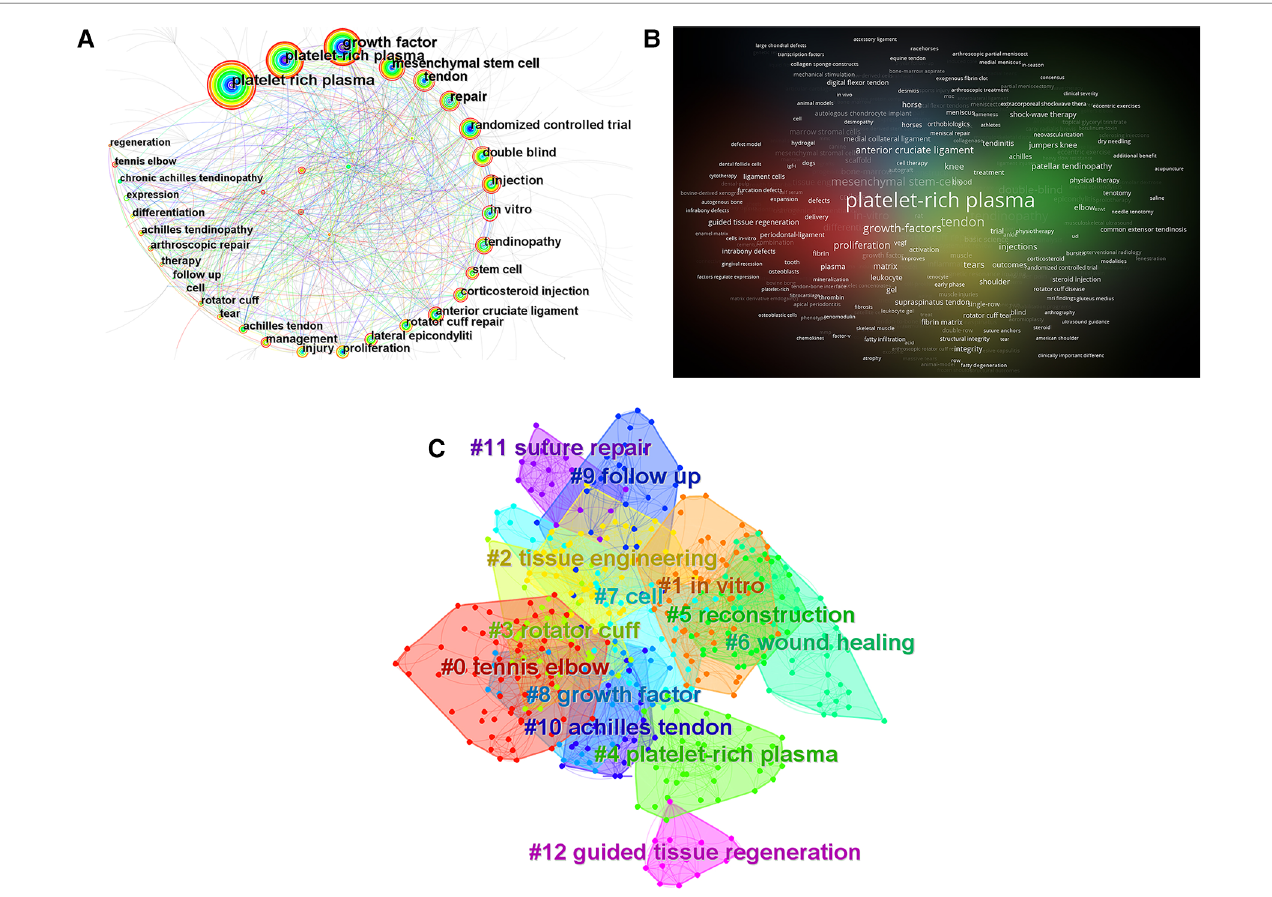
FIGURE 5 ( A ) keyword co-occurrence plot of using platelet-rich plasma to treat ligament and tendon injuries. Note: The circles in the fi gure represent keywords, and the larger the circle indicates the higher the frequency of the keyword. The dark to light colors represent the years from far to near, the connecting lines represent the links between the keywords, and the thickness of the purple outer circle represents the centrality of the keywords. ( B ) VOSviewer-based clustering density view of using platelet-rich plasma to treat ligament and tendon injuries keywords. ( C ) Cooccurrence clustering of keywords for using platelet-rich plasma to treat ligament and tendon injuries. Note: Dark to light colors represent years from distant to recent, and connecting lines represent associations between keywords.